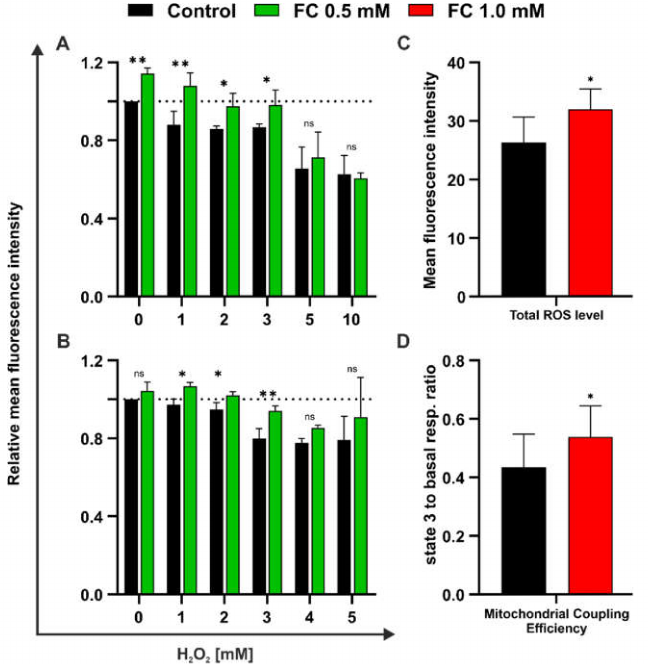
Figure 7. Effect of FC supplementation on yeast cells growing in medium containing glycerol. ( A , B ) MMP after H 2 O 2 treatment measured with flow cytometry using TMRE staining. Data